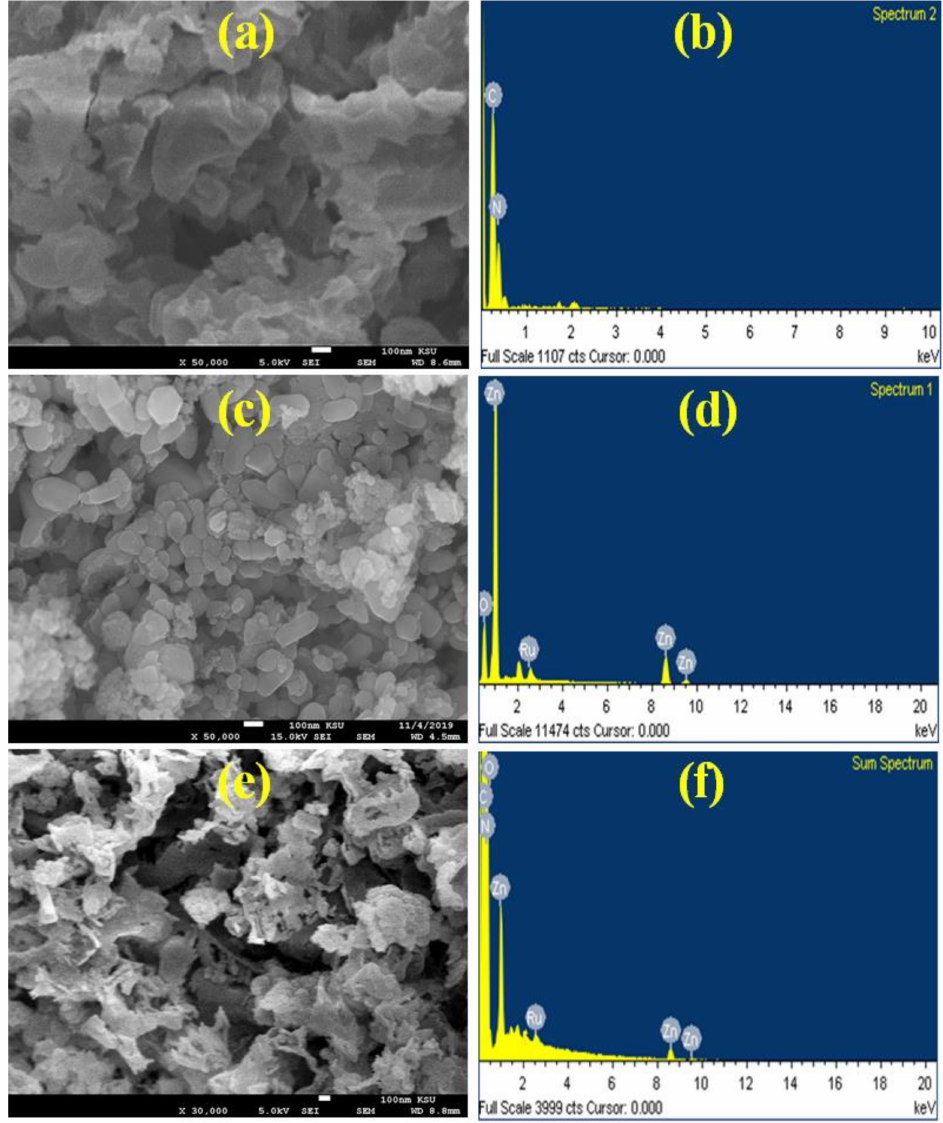
Figure 2. SEM images and EDX for the elemental composition of g-C 3 N 4 ( a , b ), Ru-ZnO ( c , d ), and Ru-ZnO@g-C 3 N 4 ( e , f